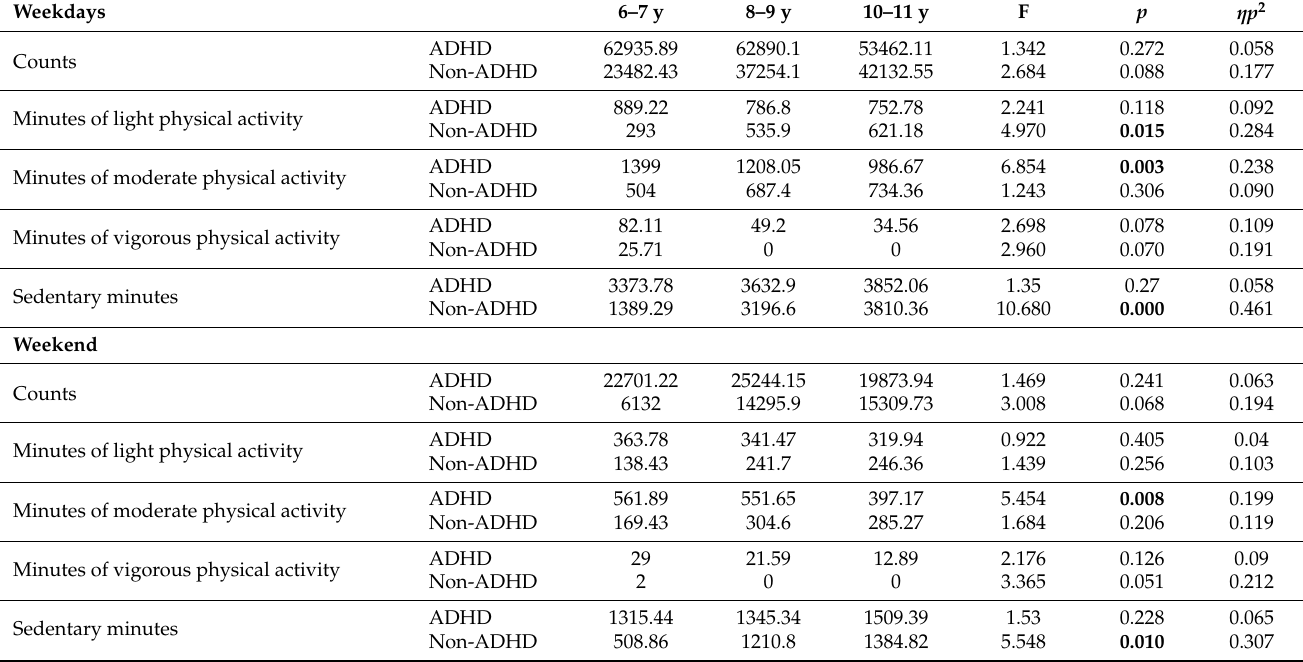
Table 5. Inter-subject effects of age on Physical Activity